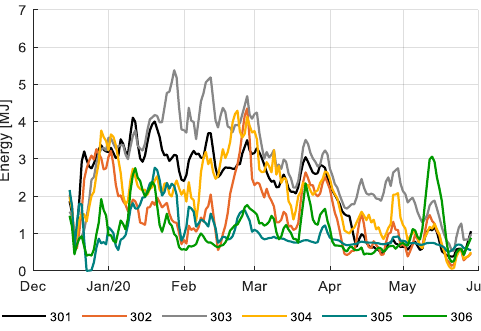
Figure 4. Heating energy usage (MJ) in the six greenhouse compartments (301–306). Data smoothed